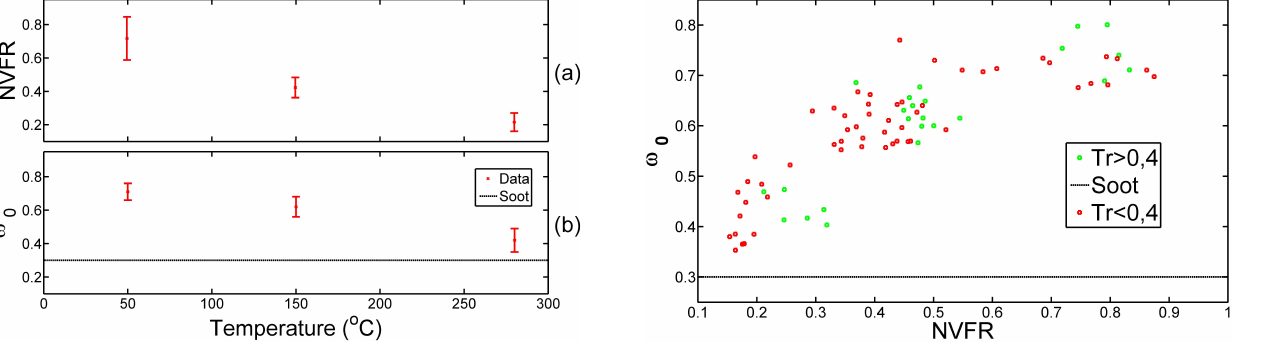
Fig. 9. The relationship between non-volatile volume fraction re- maining (NVFR) and single-scattering albedo ( ω 0 ). The measure- ments were done on the 14 April LT 10:00 to 15 April LT